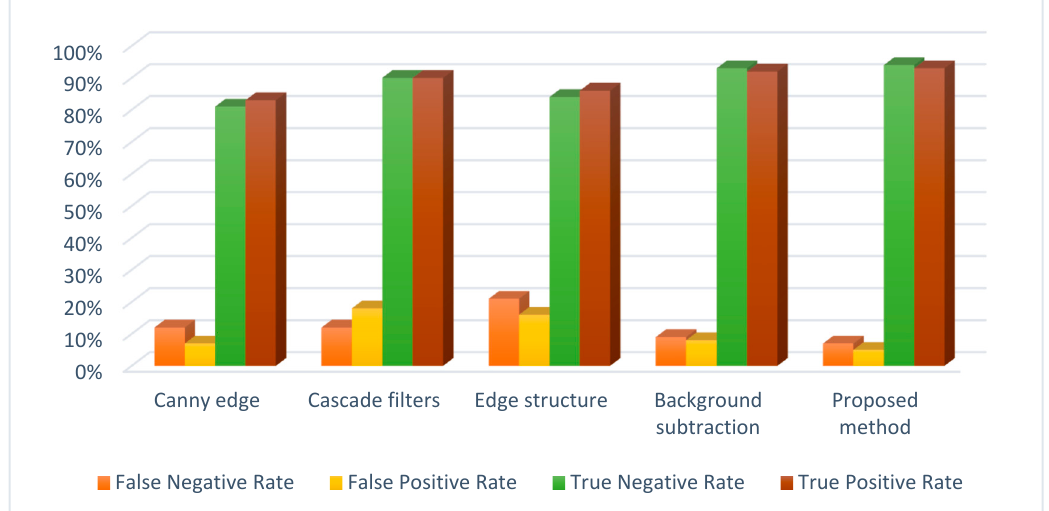
Figure 18. Success rate of identification of the detected vehicle and and comparison with other methods: Canny edge [7], Cascade filters [10], Edge structure [16] and Background subtraction [17].